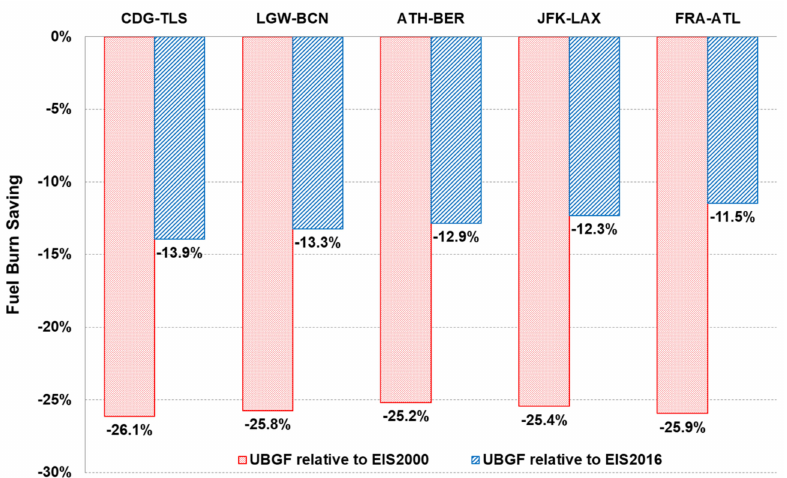
Figure 9. FB savings when using the optimized UBGF engine relative to the conventional EIS-2000 and EIS-2016